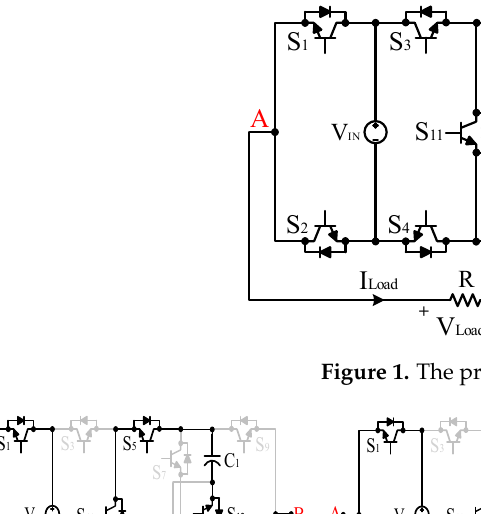
Figure 1. The proposed 9 L topology.